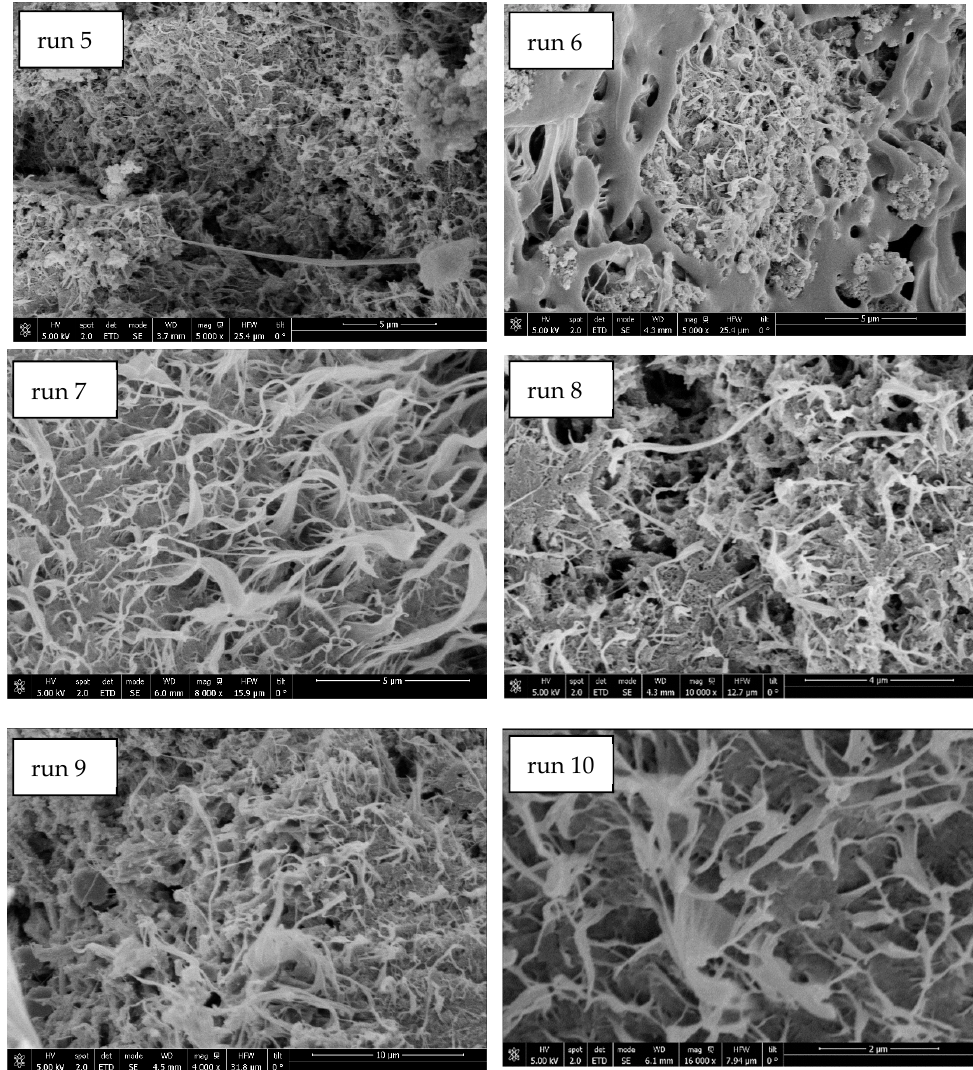
Figure 3. SEM images of the PCL:PANI scaffolds produced by runs 5 to 10.